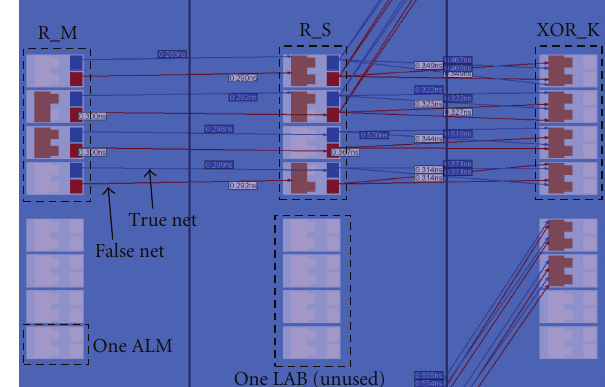
Figure 8: Vertical